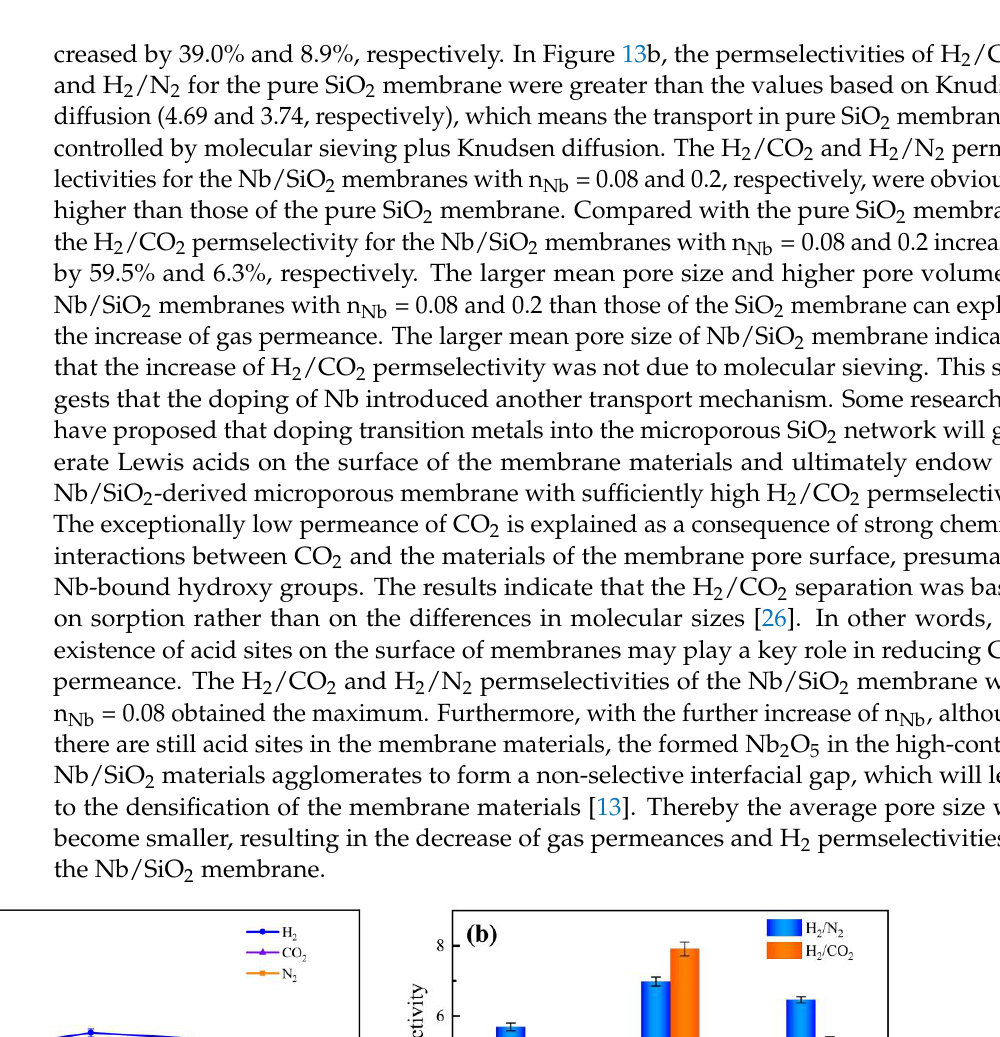
Figure 14. Effect of temperature on ( a ) H 2 permeance and ( b ) H 2 /CO 2 permselectivity of Nb/SiO 2 membranes with different n Nb at a pressure difference of 0.1 MPa. The permeance and permselectivity of the Nb/SiO 2 membrane with n Nb = 0.08 at a pressure difference of 0.1 MPa and temperature change from 25 °C to 200 °C are mani- fested in Figure 15. It can be clearly seen that H 2 permeance was significantly enhanced with increasing temperature, and the other permeances of CO 2 and N 2 were reduced slightly. The results were the same as the temperature dependency of permeance of sev- eral gases in the NS (Nb/SiO 2 ) membrane from Boffa [27]. Thus, this gives rise to the permselectivity of H 2 /CO 2 and H 2 /N 2 elevating with increasing temperature. With in- creasing temperatures, the H 2 permeance of the Nb/SiO 2 membrane increased gradually, which shows that the permeation behavior of H 2 in the membranes mainly follows an activation–diffusion mechanism. In the case of activated diffusion, molecules penetrate through the micropore while being subjected to a repulsive force from the pore walls, and the molecules with sufficient kinetic energy to overcome the repulsive force can penetrate the pores [16]. Conversely, the permeance of CO 2 and N 2 decreased slightly, similar to the trend of Knudsen diffusion, in which molecules collide with the pore walls more regularly than permeating molecules.